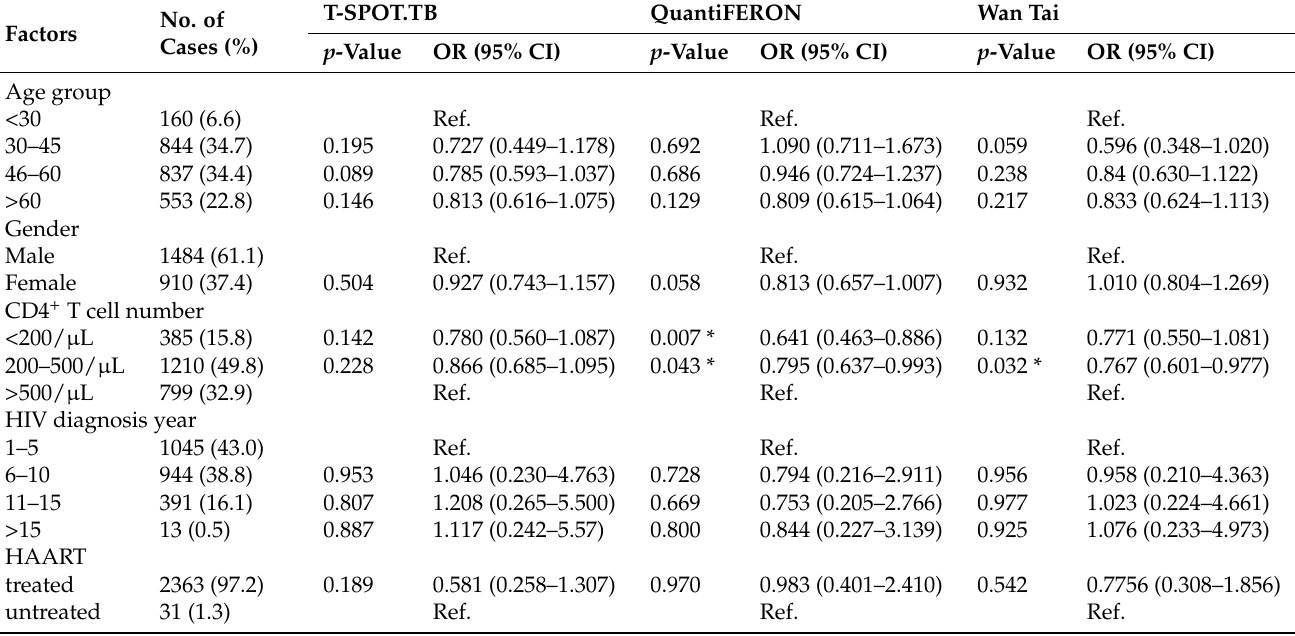
Table 2. Univariate analysis of factors associated with the three IGRA